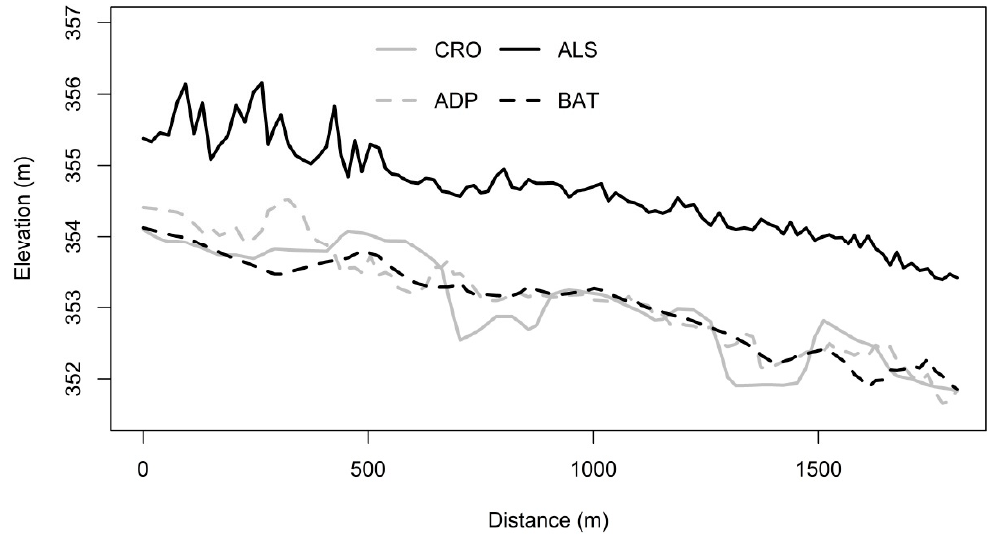
Figure 8. Visual comparison of thalwegs. Table 7. RMSE and MAE values for the compared DEMs (thalweg comparison).